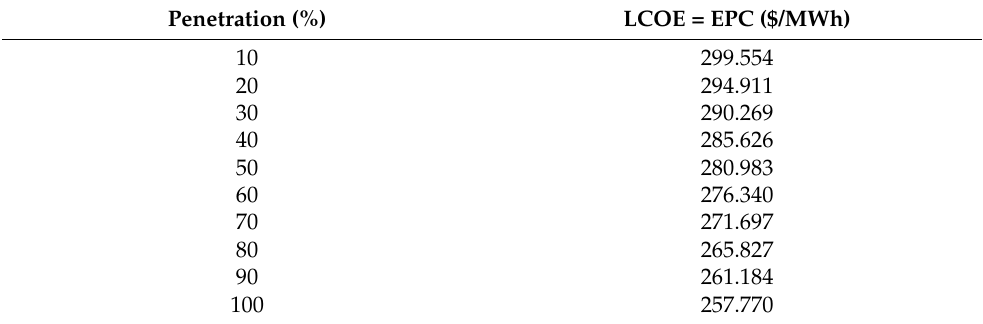
Table 4. LCOE and